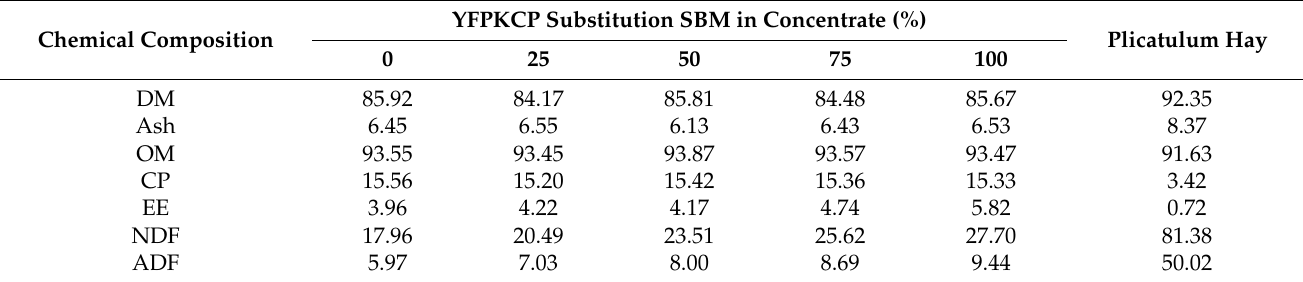
Table 2. Chemical composition of the experimental diets and plicatulum hay (% DM basis). Chemical